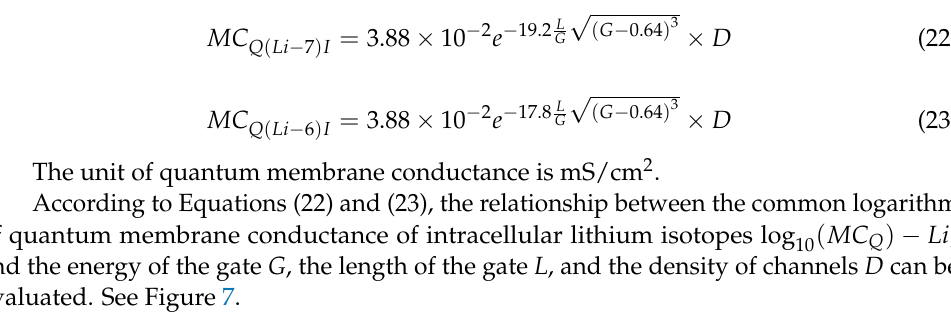
( MC ) − Li E and the energy of Q 10 ( MC ) − Li E and the length of the gate L by Q 10 ( MC ) − Li E and the membrane potential V m by setting Q 10 ( MC ) − Li E and the density of channels D by Q 10